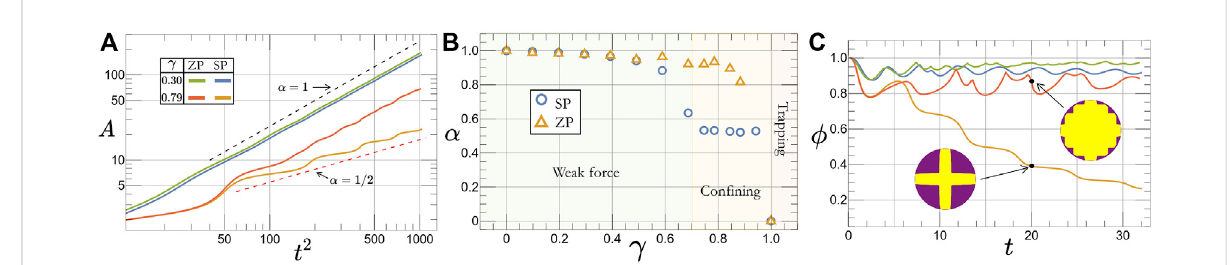
FIGURE 2 Isochrone areaanalysisinthe2Dperiodicpotential. (A) Isochrone areaasafunctionofsquaredtimeforZPandSPandtwovaluesoftherelative force strength γ , respectively, in the weak force and con fi ning regimes. (B) Best fi t of the exponent α (de fi ned in the main text) showing different scalingsbetweenSPandZPinthecon fi ningregime. (C) Fractionalareacoveredbytheisochronesasafunctionoftime;thelegendisthesameas (A) . The insets showtheouter boundary oftheisochrones (yellow region)enclosed inthecorrespondingboundingdisk (purple) forboth policies at t = 20 and γ =